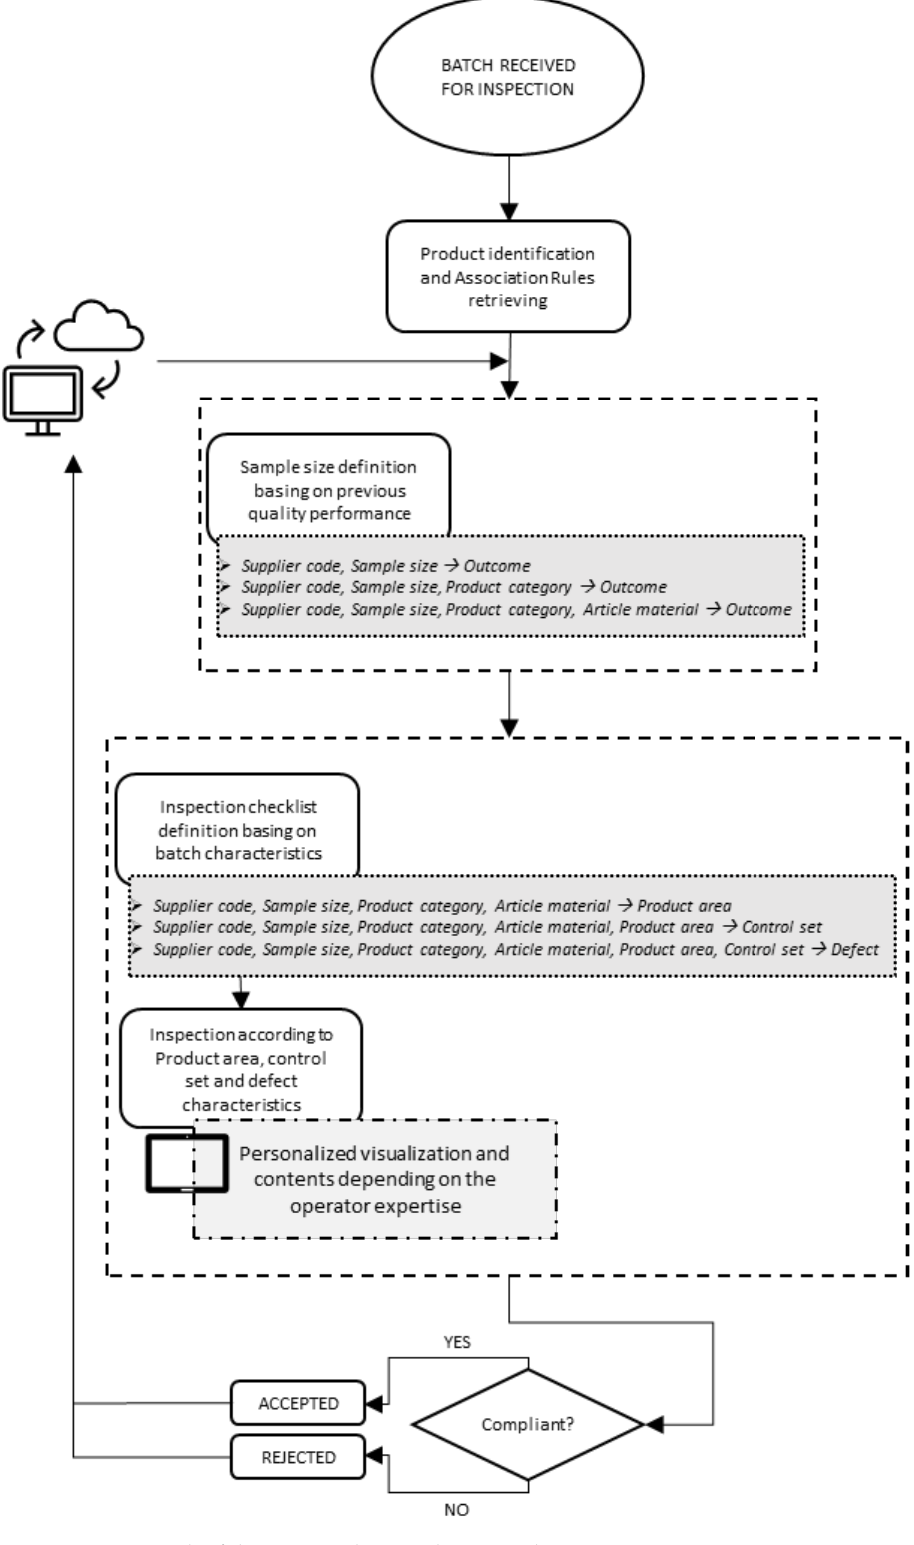
Figure 1. Framework of the proposed research approach .